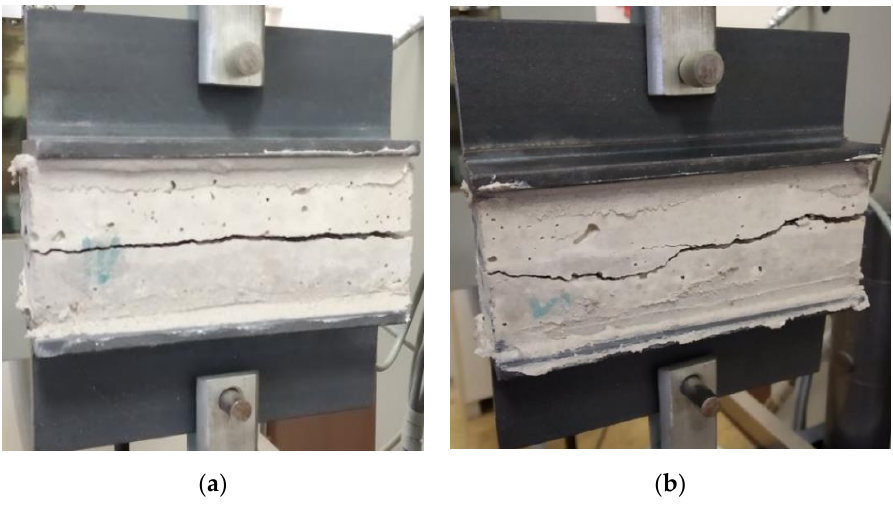
Figure 11. Specimen crack patterns: ( a ) regular failure on the layer interface areas and ( b ) an irregular crack.